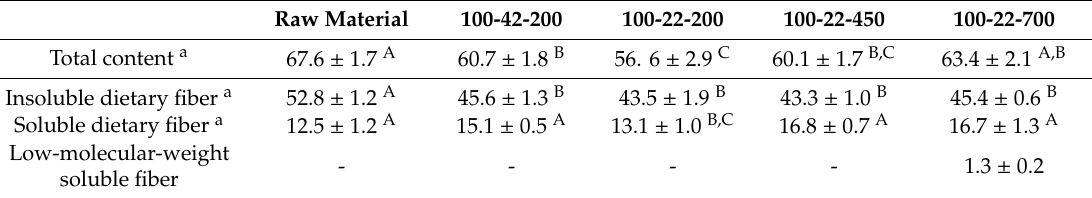
Table 1. Insoluble, soluble, and low-molecular-weight soluble dietary fiber contents (g / 100 g dry matter) of raw and extruded apple pomace (mean value ± standard deviation, n = 3). For all samples, the barrel temperature was 100 ◦